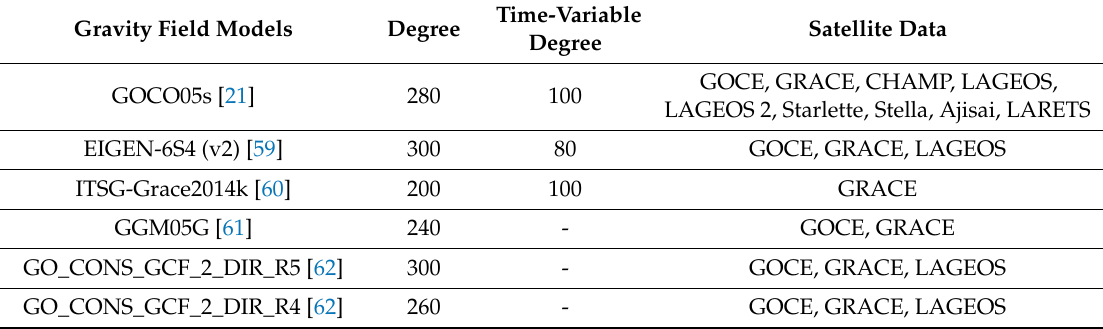
Table 2. Satellite data and maximum degree (static and time-variable part) of the used gravity field